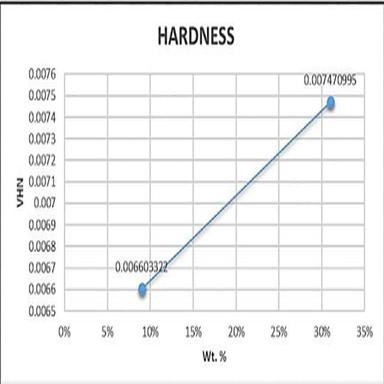
Wt. % of Nano Composition Vs Harness (HV).